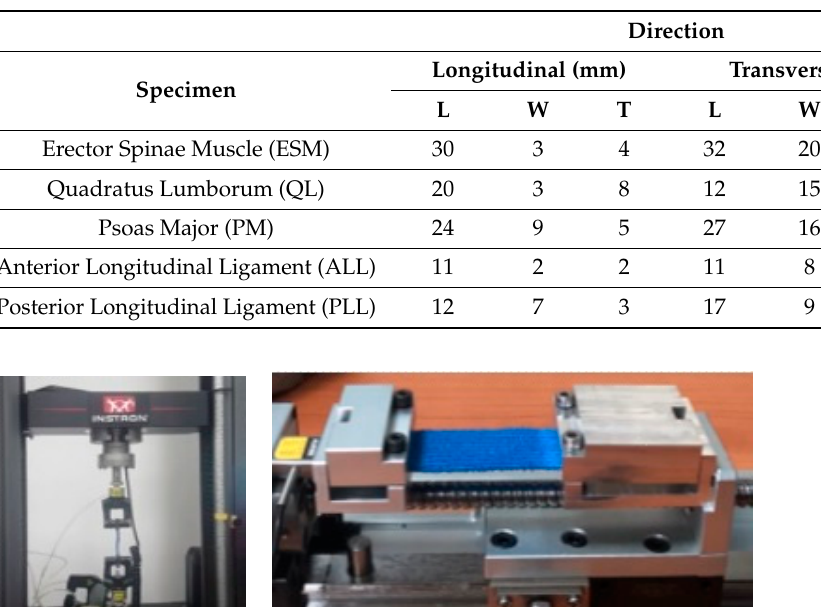
Table 1. Sample dimension. L denotes length, W denotes width, and T denotes a thickness.